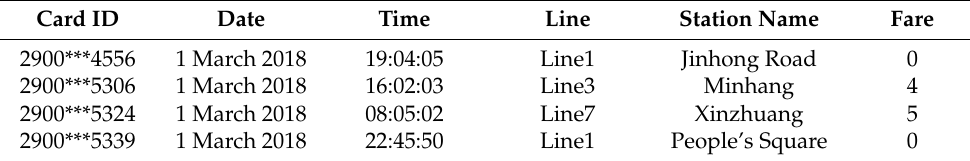
Table A2. Examples of the